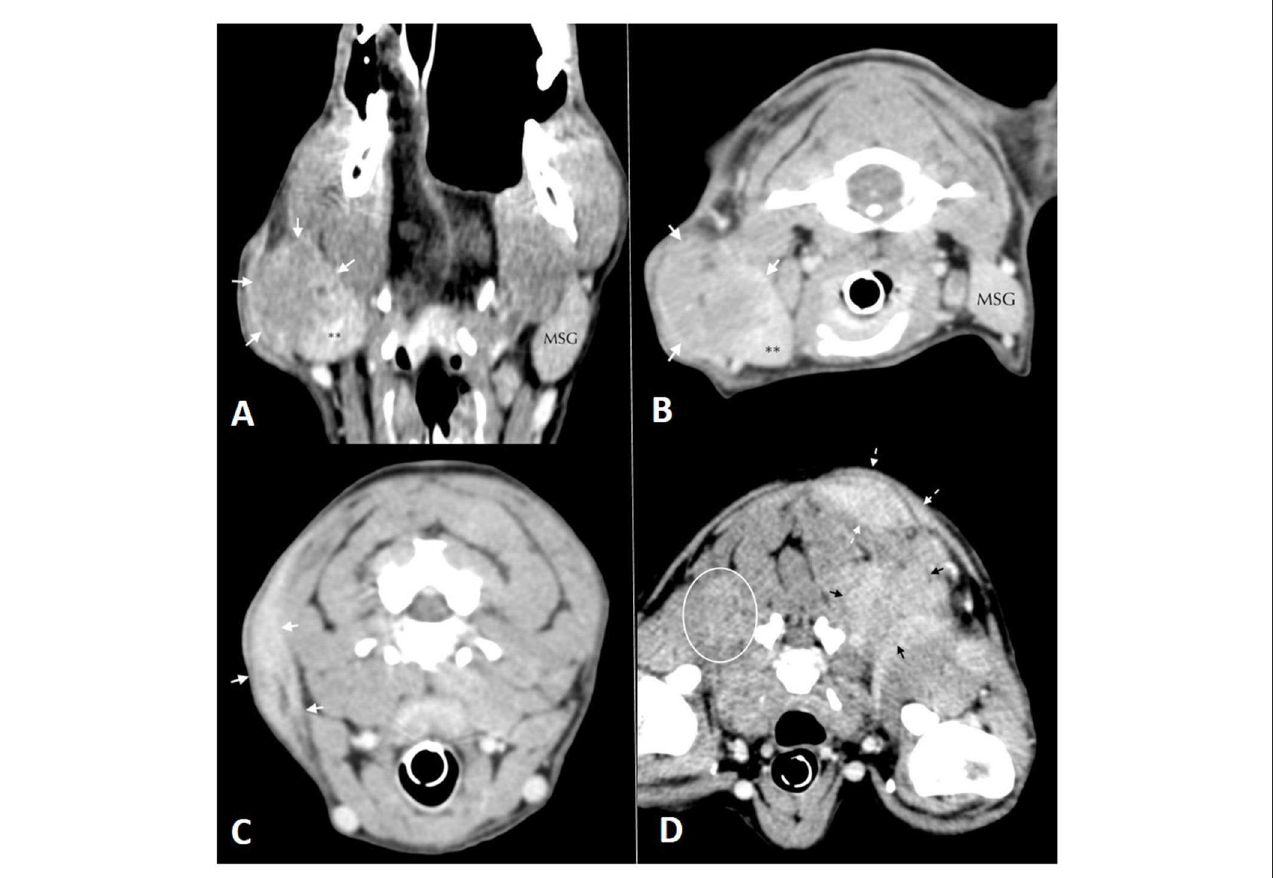
FIGURE2 Soft tissue window computed tomographic images. (A) (left) and (B) (right): in (A) dorsal and (B) transversal planes oriented with the patient’s right side on the left of the image. Mass lesion (white arrows) arising from the lateral margin of the right mandibular salivary gland**. The left mandibular salivary gland (MSG) is labeled for comparison. (C) (left), (D) (right): Soft tissue window computed tomographic images in the transverse plane, oriented with the patient’s right side on the left of the image. Images show multiple mass lesions arising from the (C) subcutaneous tissues of the right aspect of the neck (white arrows), (D) poorly defined hyper-contrast enhancing mass lesions in the musculature deep to the scapulae bilaterally (white oval and black arrows) and more well-defined mass lesions within the dorsal, left subcutaneous tissues (dashed white arrows).